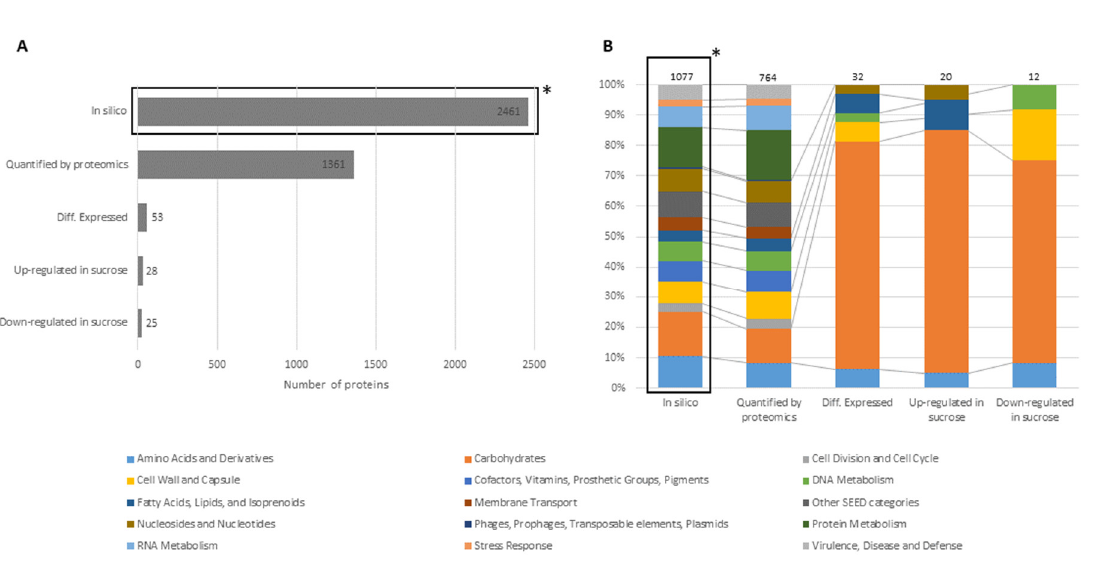
Figure 1. Comparison of the putative functional proteome (in silico) with protein sub-groups obtained by MS intensity statistical analysis of cellular proteomes. ( A ) Total protein counts of in silico predicted proteins, proteins quantified by proteomics (detected in four out of five replicates of at least one group), differentially expressed proteins and up- and down-regulated proteins in sucrose. ( B ) Corresponding SEED category distributions. The SEED subsystem proteome coverage was around 44%. (*) Derived from Di Xu et al. [36] .